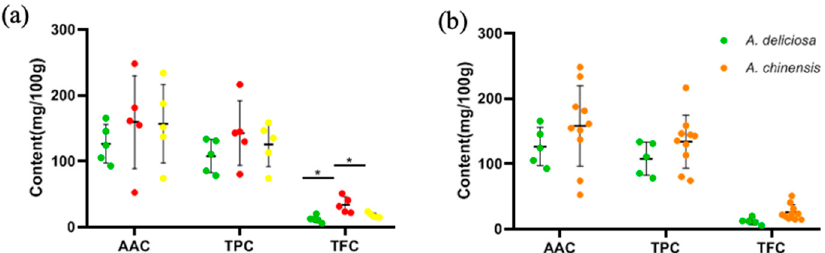
Figure 5. The distribution of AAC, TPC and TFC ( a ) in different flesh colors and ( b ) in two species. The colors of the dots in ( a ) are consistent with flesh color.